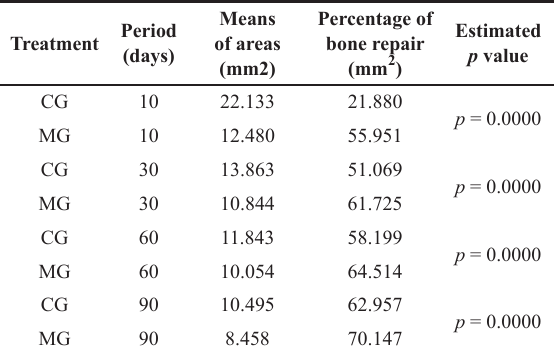
Figure 3 - Mean percentage of bone repair displayed by period of observation, for animals of groups control (CG) and MSC-treated (MG) and estimated p values comparing data of % of bone filling, per period, of treatment MG versus treatment